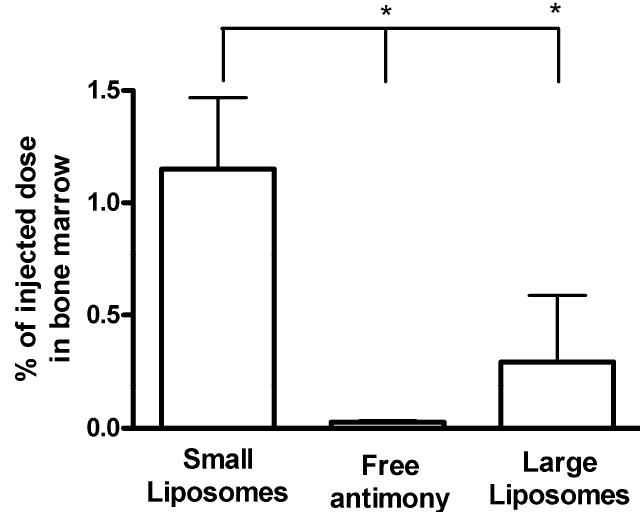
Figure 4. Influence of liposome encapsulation and of vesicle mean diameter on antimony level in the bone marrow of infected dogs, 96 h after intravenous bolus injection of meglumine antimoniate. Small liposomes (mean vesicle diameter of 400 nm) were given at 4 mg Sb/kg of body weight (n = 5). Large liposomes (mean vesicle diameter of 1,200 nm) were given at 5.5 mg Sb/kg of body weight (n = 10). Meglumine antimoniate was given at 100 mg Sb/kg of body weight (n = 5). Data are given as means ± standard deviation. * P <0.001 for One-way ANOVA followed by Bonferroni post-test. Adapted from Ref.